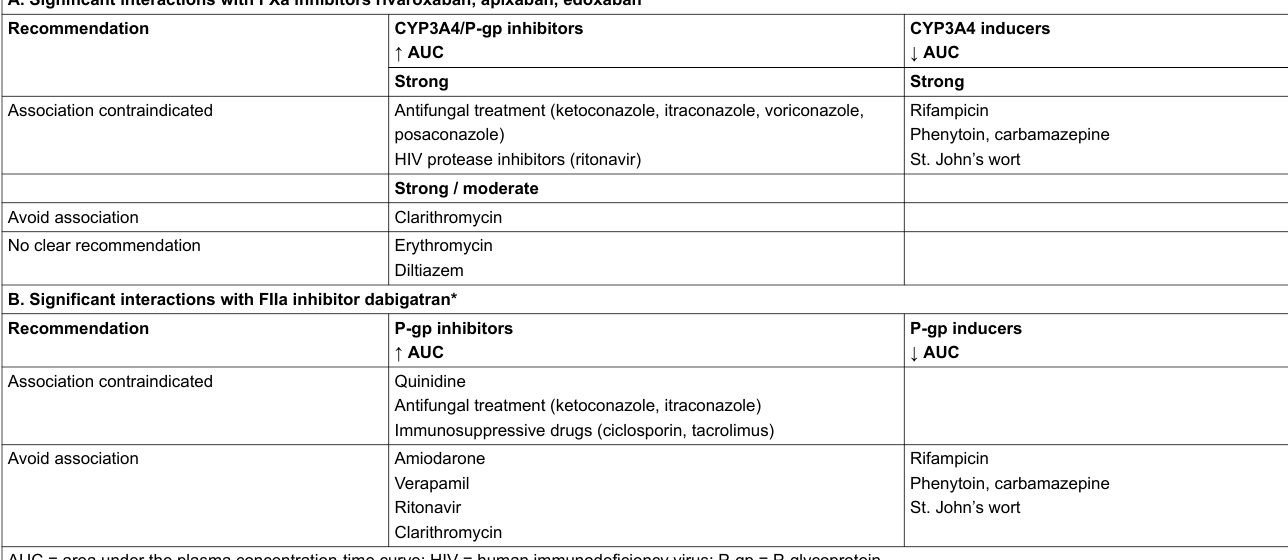
Table 4 : Effect of direct oral anticoagulants on routine haemostasis assays and thrombophilia screening. Assay aPTT ↑ ↑ Prothrombin time ↓ ↓ Fibrinogen ↔ ↓ Thrombin time ↔ ↓ Anti-Xa activity ↑ ↔ Anti-IIa activity ↑ Genetic analysis Possible Antithrombin, proteins C and S (activity) Not possible (false negative) Lupus anticoagulant Not possible (false positive) Anticardiolipin and anti-B2GP1 antibodies